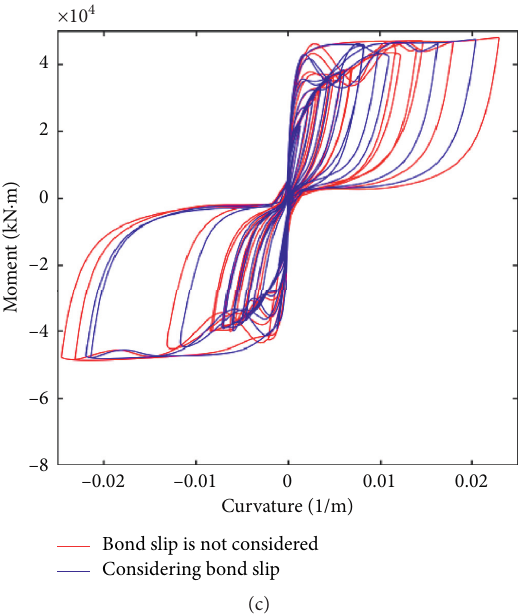
Figure 7: . Analysis of moment-curvature curves: (a) Northridge wave; (b) Taiwan wave; (c) Duzce wave.